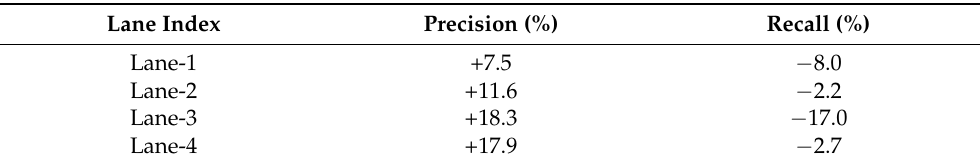
Table 9. The comparison of ResNet18 between vision information only and the fusion input (LLNet with one head in vision module). Lane Index